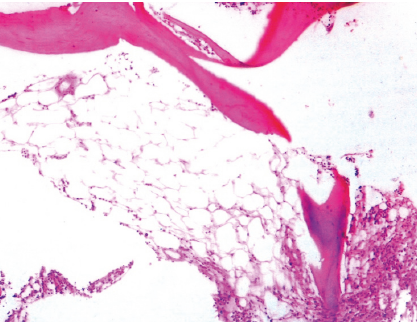
Figure 3: Post therapy histological section of bone marrow biopsy showing extensive necrosis (400x